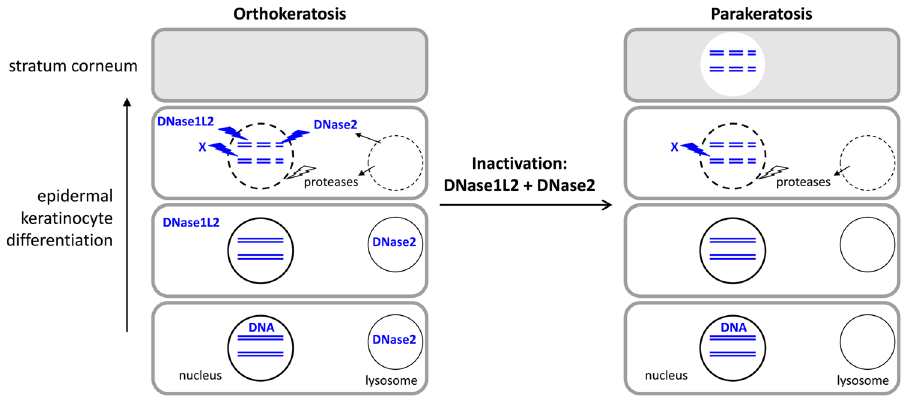
Figure 5. Schematic model of DNA degradation steps during stratum corneum formation. This schematic drawing summarizes steps of the DNA degradation process during cornification of interfollicular keratinocytes, as inferred from the results of this study. X, unidentified neutral